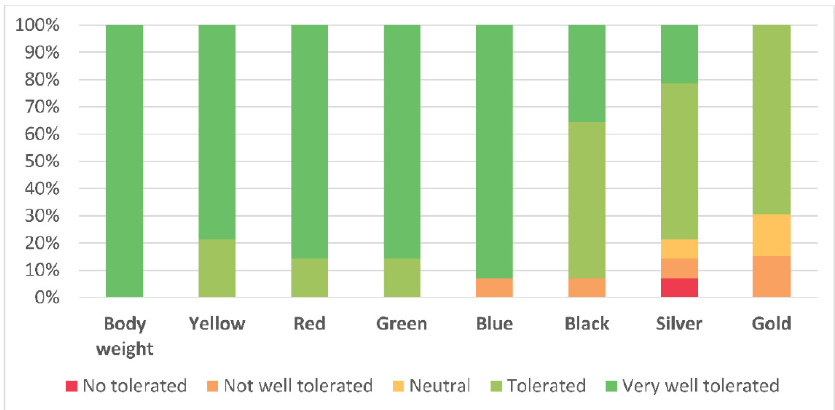
Figure 8. Percentage of intensity-related pain for every condition.